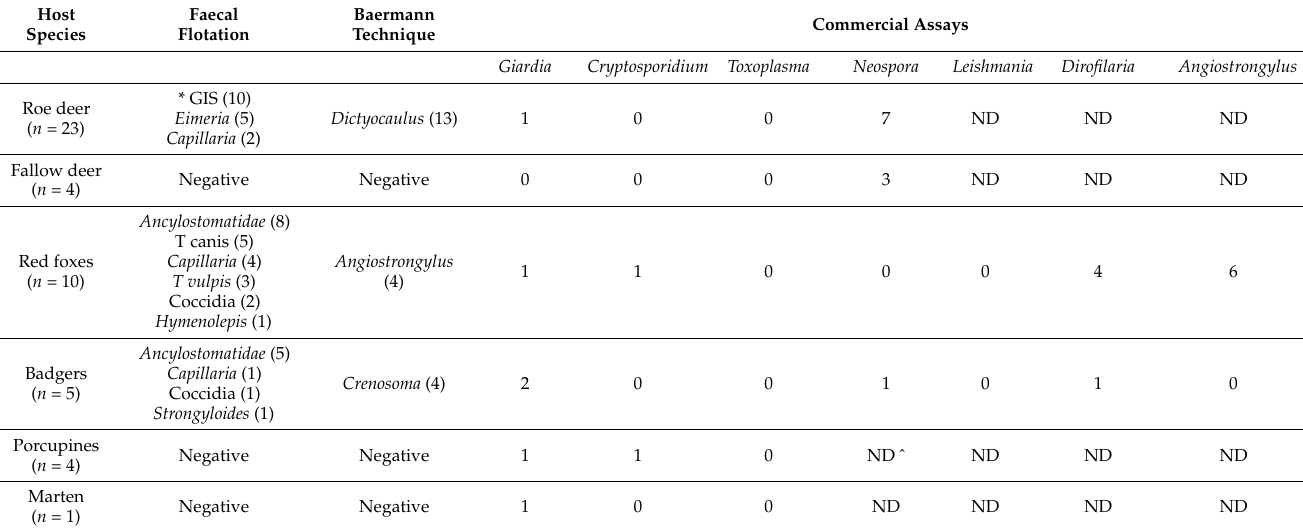
Table 5. Parasite infections found by faecal flotation, the Baermann technique, and different com- mercial assays in the cohort of 47 wildlife animals examined. * GIS = Gastrointestinal strongyles; ˆ ND = Not